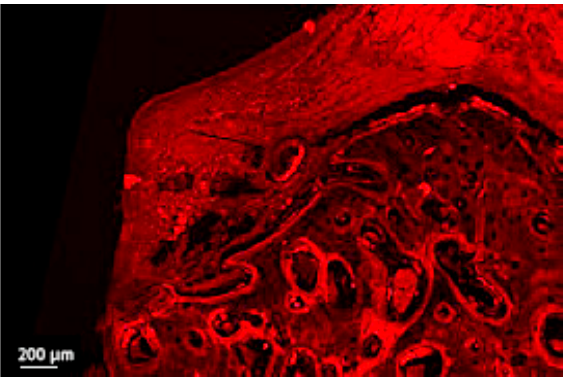
Figure 6. Detail of the soft tissue bone in a thick section of a non-ligated implant. Note the ulcerated buccal pocket epithelium, the interrupted epithelial lining, the infiltration of inflammatory cells and the disruption of collagen network (implant #2, oral aspect; bar, 200 µm).